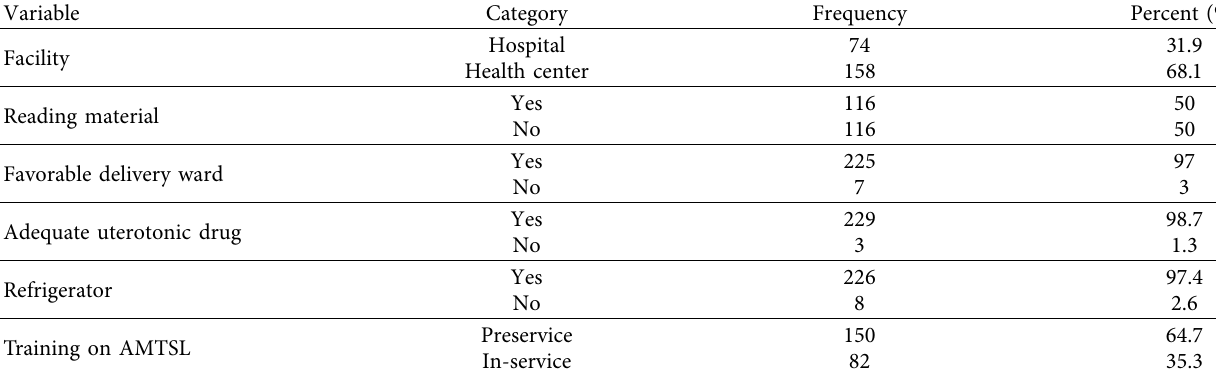
Table 3: Health institution and training information of respondents,